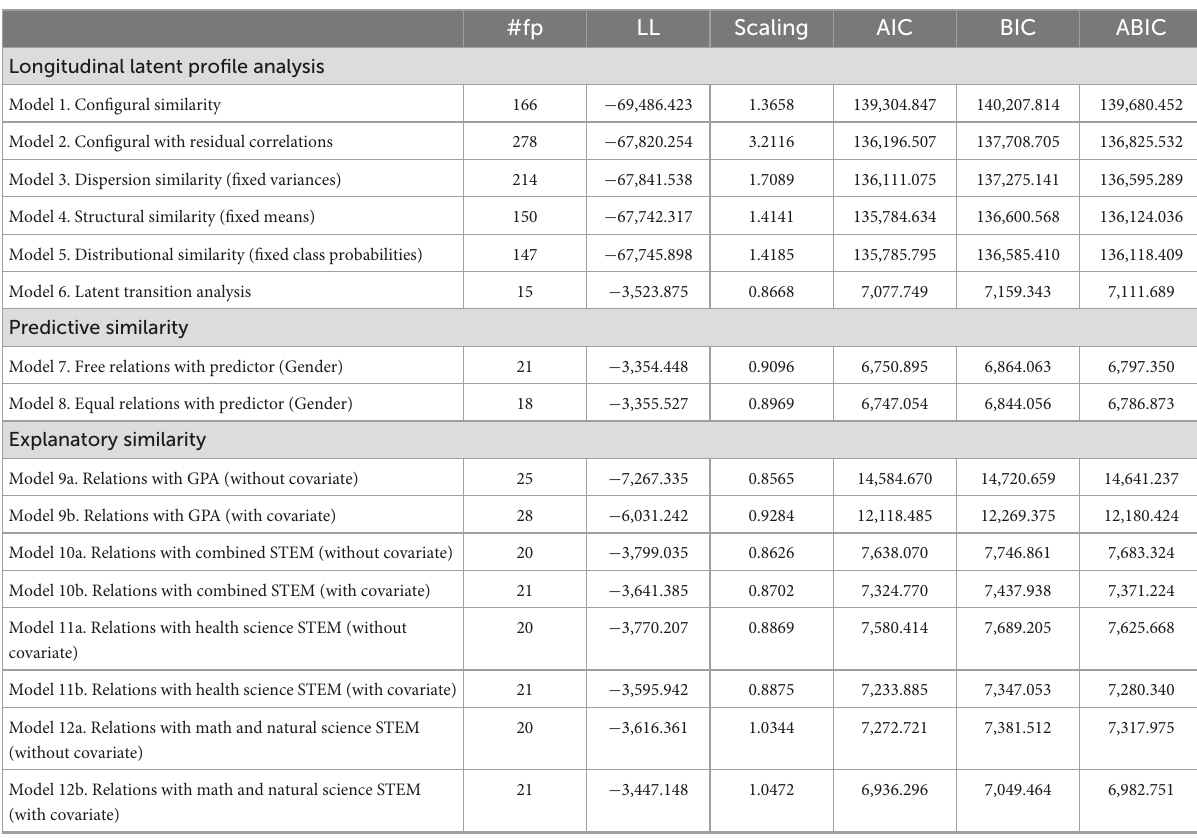
TABLE 4 Model fit criteria for the latent transition